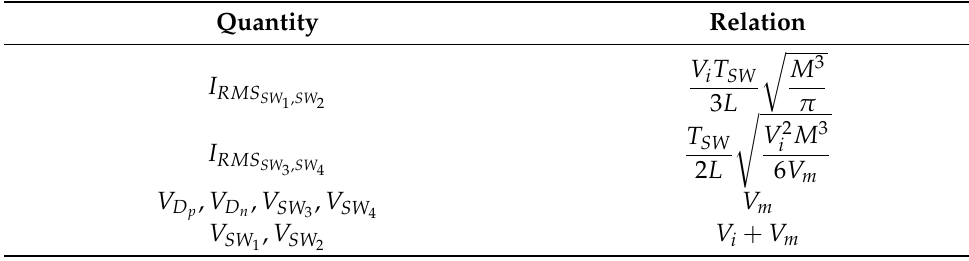
Table 3. Current and voltage